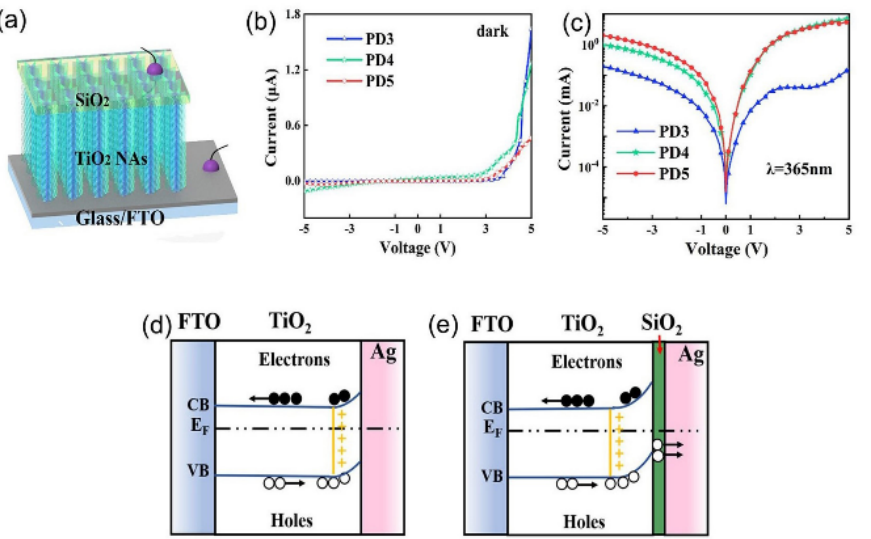
Figure 1. ( a ) The diagram of the TiO 2 /SiO 2 mixing device. ( b , c ) I − V curves of TiO 2 /SiO 2 hybrid devices under two conditions of darkness and light. ( d , e ) Energy band diagram of PD in TiO 2 NAs and TiO 2 /SiO 2 mixed devices. Reproduced with permission from Ref. [9]; published by Elsevier BV, 2021.